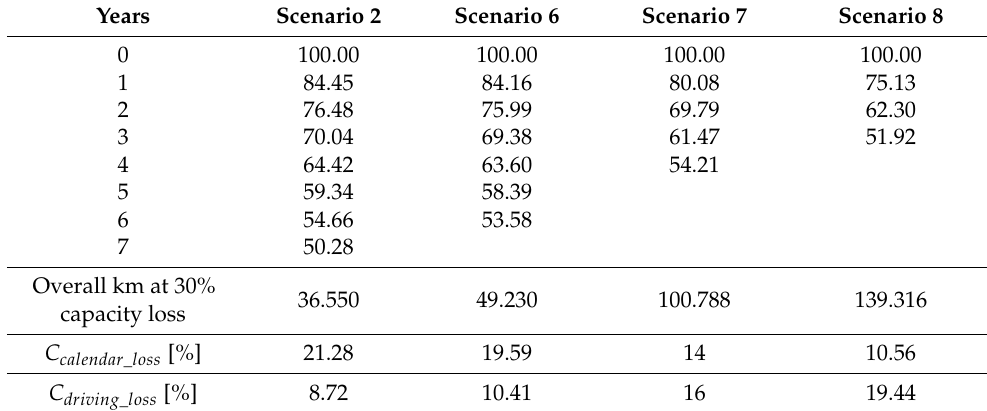
Table 16. Estimated capacity loss percentage in the vehicle according to the scenarios @ 35 ◦